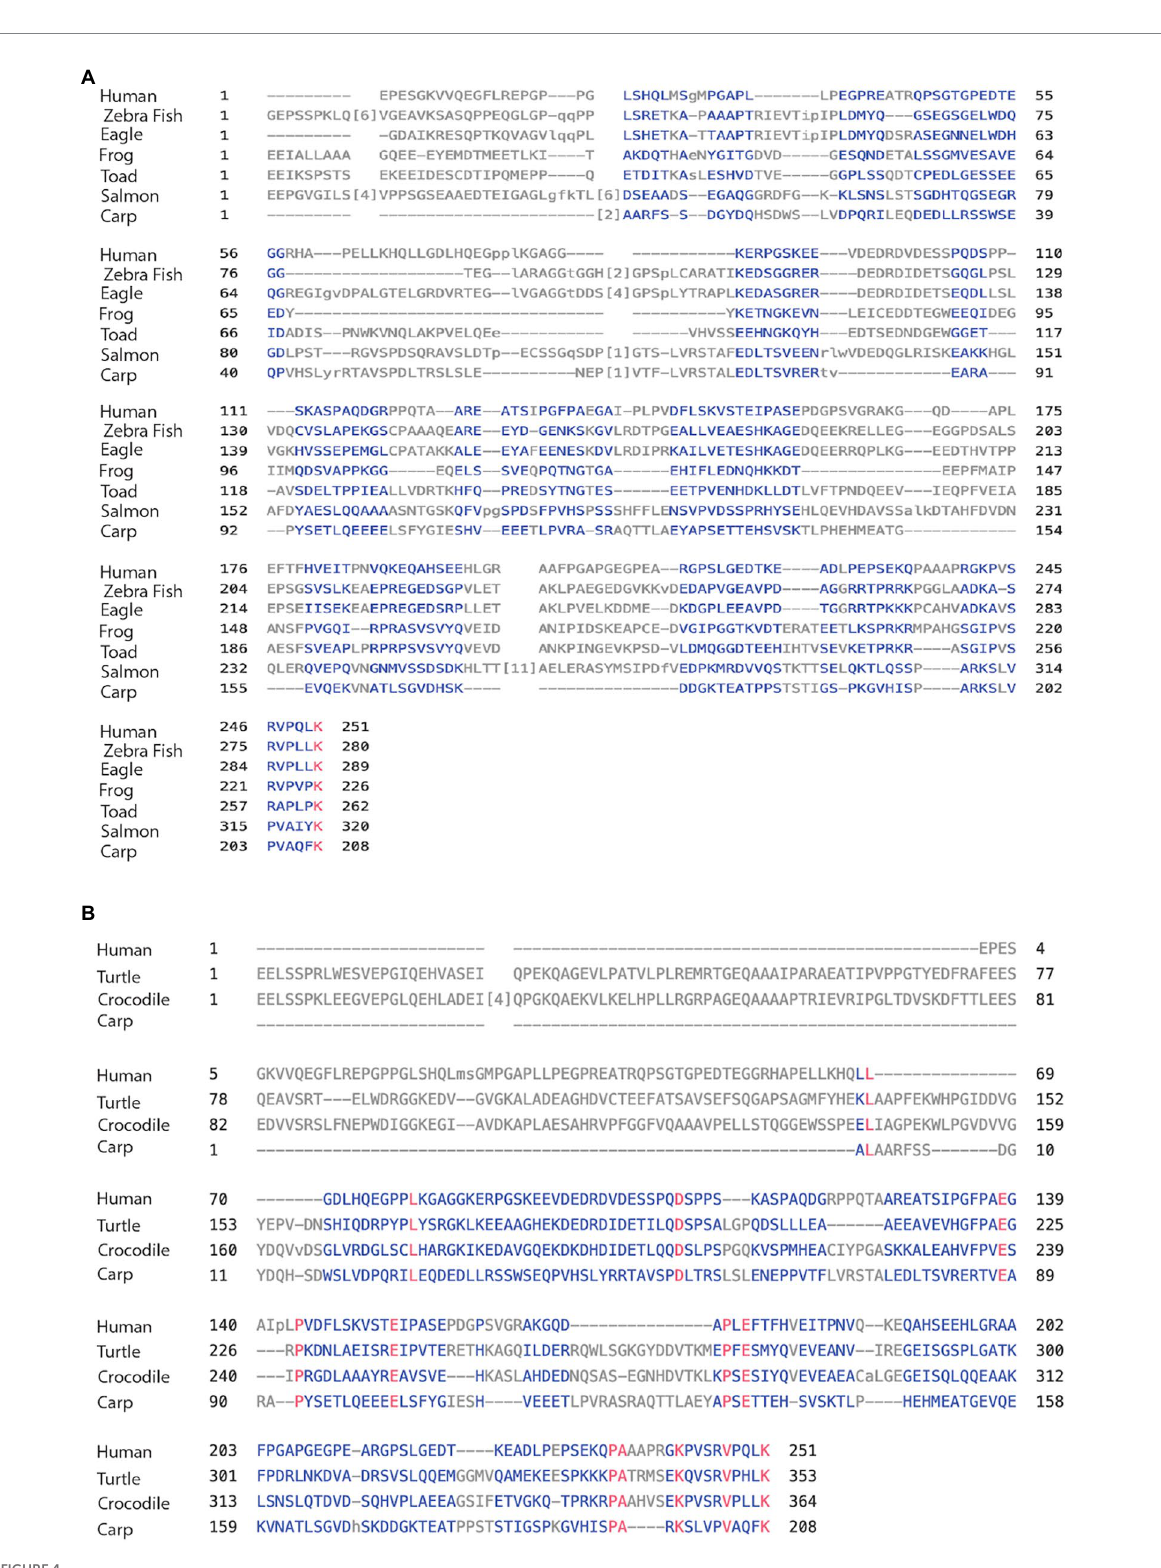
FIGURE 4 (A) Alignment of exon 4a in non-mammal vertebrates. Using the multiple alignment tool of COBALT for analysis of the 4a exon in vertebrates including human, zebra finch, eagle, frog, toad, salmon, and carp. (B) Alignment of exon 4a-L in non-primate vertebrates. Using the multiple alignment tool of COBALT for analysis of the 4a-L exon in vertebrates including human, turtle, crocodile, and